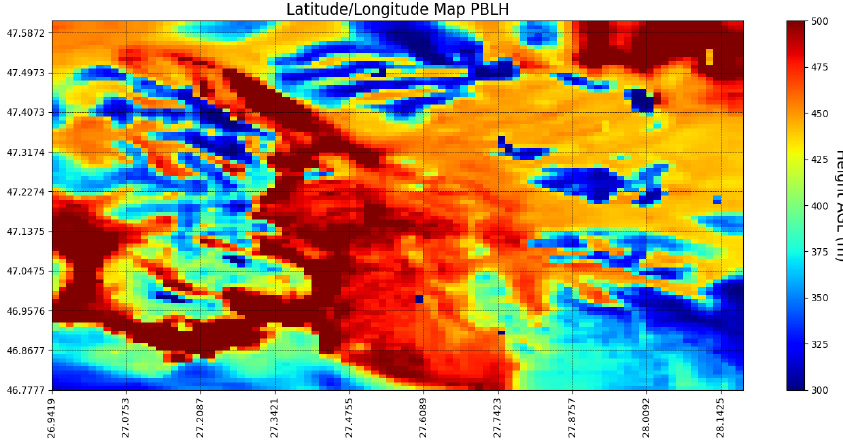
Figure 4 . Example of a WRF output map (PBLH); 3 rd nest, in center of nest: Ia și ; 04/04/2016, 08:00 UTC; YSU parametrization.